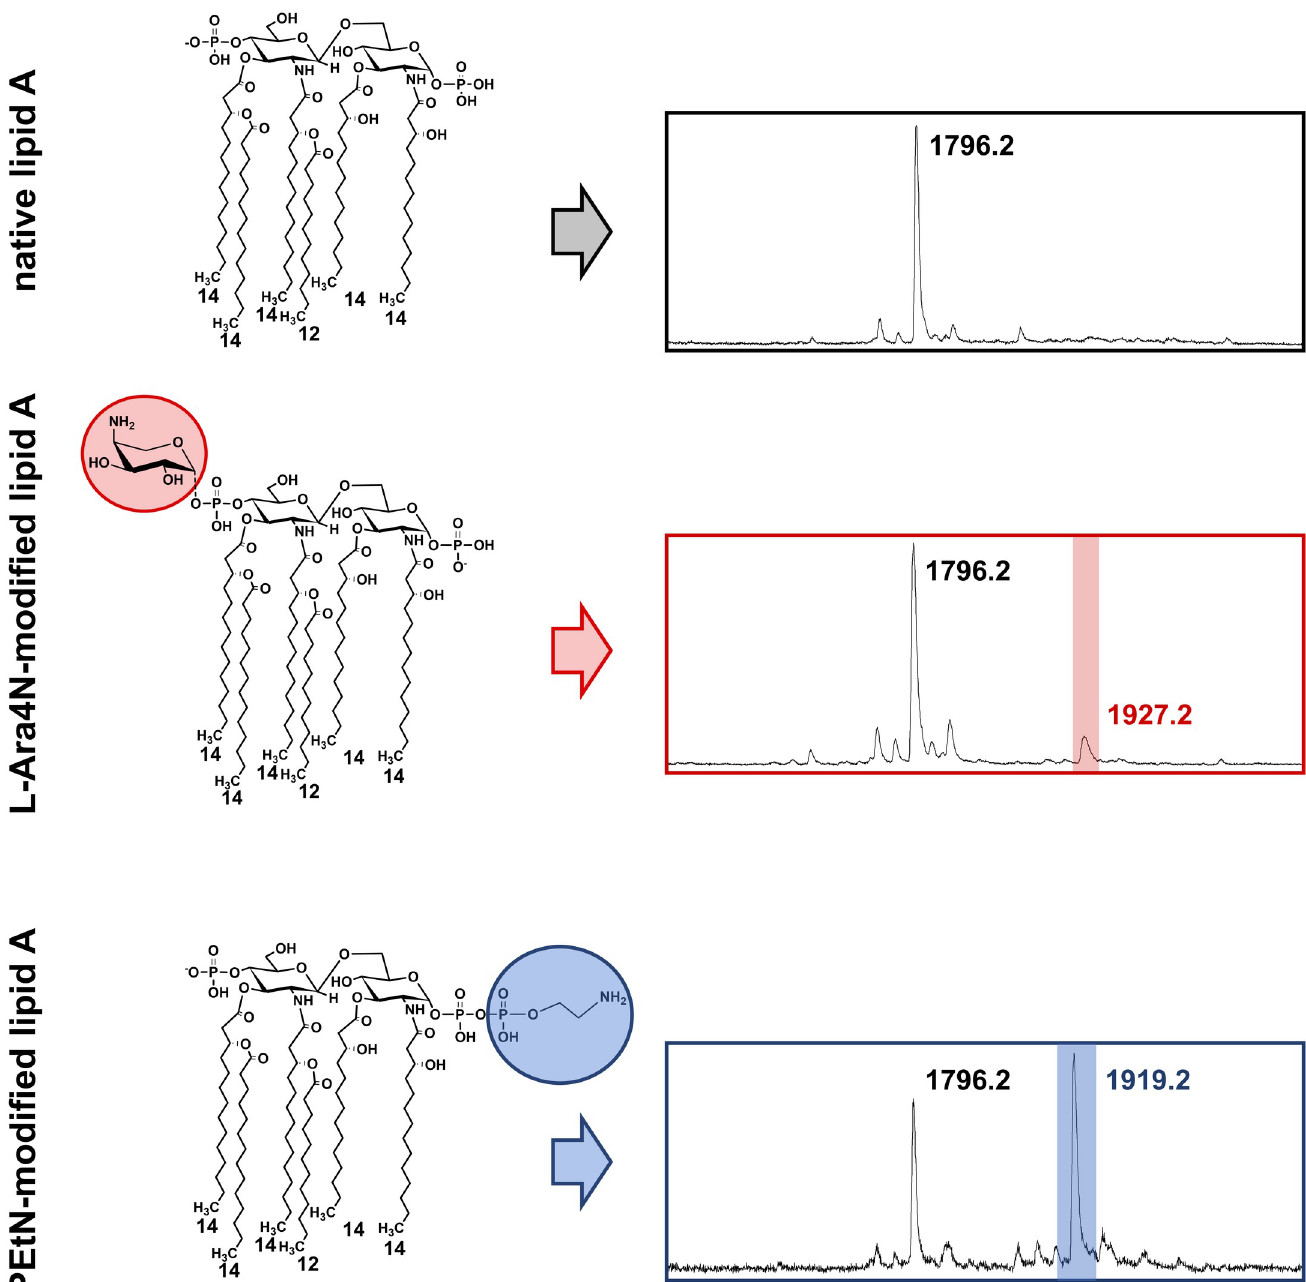
Fig 1. (Left column) Structures of the native (top) and modified (middle and bottom) lipid A portion of the Escherichia coli LPS. L-Ara4N (marked in red) and PEtN (marked in blue) modifications to lipid A cause resistance to polymyxin antibiotics. L-Ara4N modification of the 4´-phosphate of native lipid A is characteristic of colistin-resistant E . coli strains carrying chromosomal mutations; this modification often co-occurs with PEtN modification of the 1-phosphate of the lipid A structure. Lipid A from strains expressing MCR enzymes is only modified by PEtN. (Right column) Lipid A spectra obtained from intact E . coli colonies using the MALDI Biotyper Sirius system (Bruker Daltonics) and the adapted MALDIxin protocol [18]. Spectra obtained from colistin-susceptible strains have one major peak at m/z 1,796.2 (top), corresponding to native lipid A. Depending on the mechanism of colistin resistance, spectra from colistin-resistant strains have additional peaks at m/z 1,927.2 (middle, marked in red), due to L-Ara4N modification of lipid A, and/or at m/z 1,919.2 (bottom, marked in blue), due to PEtN modification of lipid A. LPS, lipopolysaccharide; L-Ara4N, 4-amino-4-deoxy-L-arabinose; PEtN, phosphoethanolamine; MCR, mobile colistin resistance; m/z , mass-to-charge